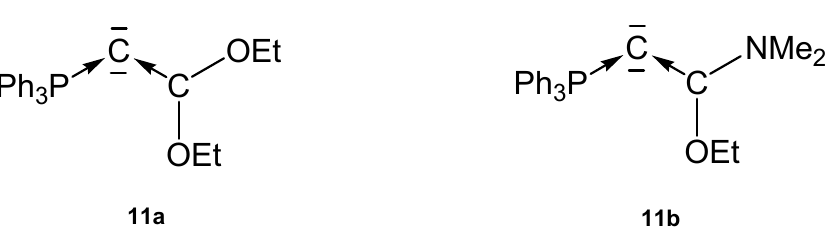
Figure 14. In compounds 11 the C(0) atoms are stabilized by a phophine or a carbene ligand. Table 10. Transition metal complexes with the mixed carbones 11a and 11b. 31 P NMR shifts in ppm.